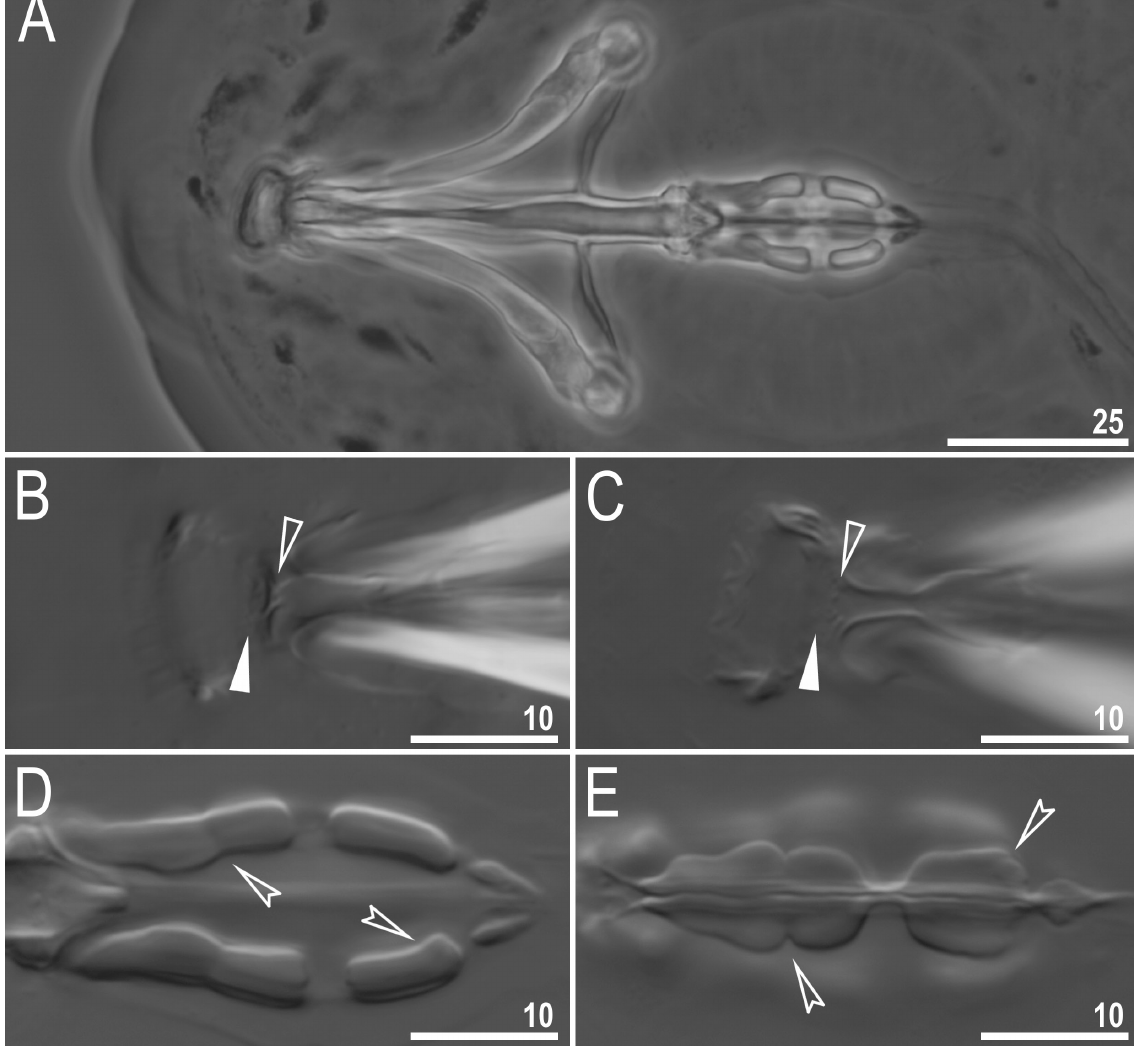
Fig. 15. Tenuibiotus zandrae sp. nov. Buccal apparatus and the oral cavity armature seen in LCM. A . Dorso-ventral projection of the entire buccal apparatus (holotype, IZiBB, slide GL.011.17, PCM). B – C . Oral cavity armature seen in NCM, dorsal (B, paratype) and ventral (C, holotype) view, respectively. D – E . Placoid morphology seen in NCM, dorsal (D) and ventral (E) view, respectively (both holotype). Filled flat arrowheads indicate faintly visible second band of teeth in the oral cavity, empty flat arrowheads indicate the third band of teeth in the oral cavity, empty indented arrowheads indicate central constrictions in the first macroplacoids and the subterminal constriction in the second macroplacoid. Scale bars in